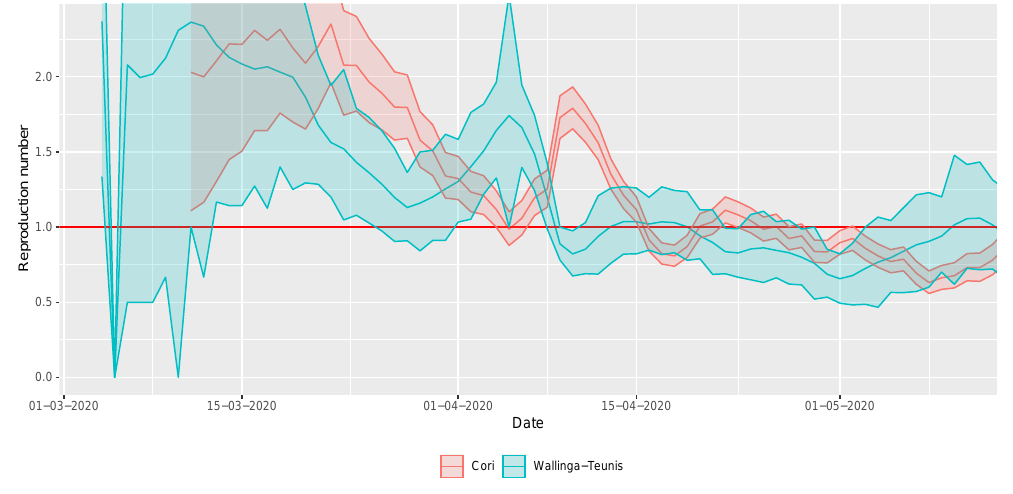
Figure 6. Real-time estimation of the reproduction number during the early phase of the COVID-19 outbreak in Hungary using two different methods (shaded area depicts 95% confidence interval).